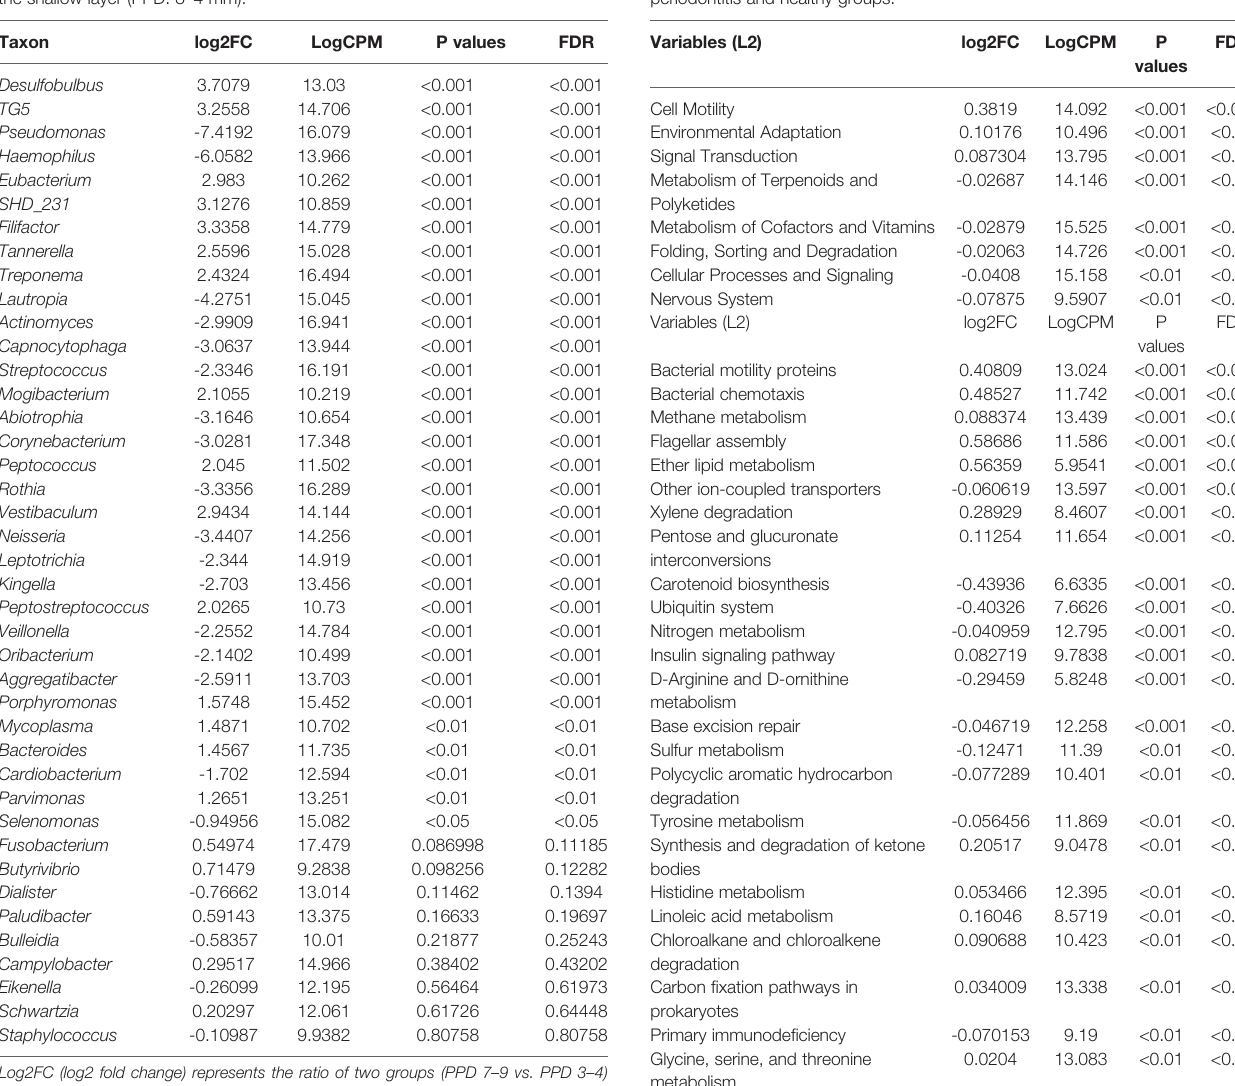
TABLE 4 | Signi fi cant functions and pathways on L2 and L3 compared with periodontitis and healthy groups. Variables (L2)